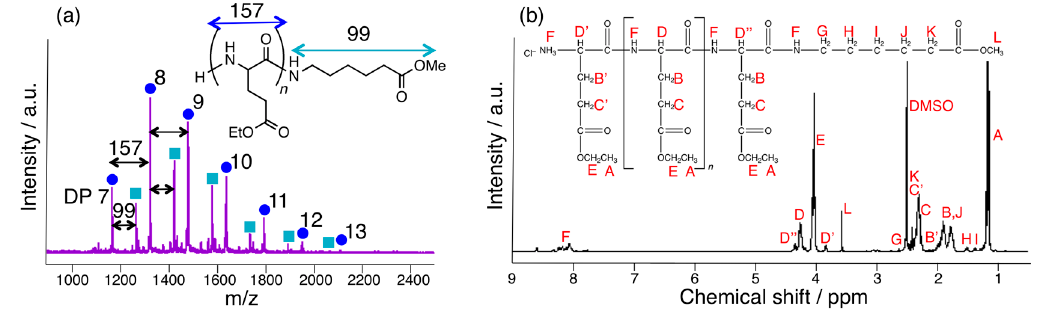
Figure 5. MALDI-TOF MS ( a ) and 1 H-NMR ( b ) spectra of the papain-catalyzed reaction product using Glu(Et) 2 with nylon 6Me as substrates. The mass spectrum was obtained in linear positive mode using HABA and Na-TFA as the matrix and cationic reagent, respectively. Peaks with blue circles denote oligo(GluEt) with various DP, and peaks with turquoise squares denote oligo(GluEt) with a nylon 6Me. DMSO- d 6 was used as the solvent in NMR measurements.